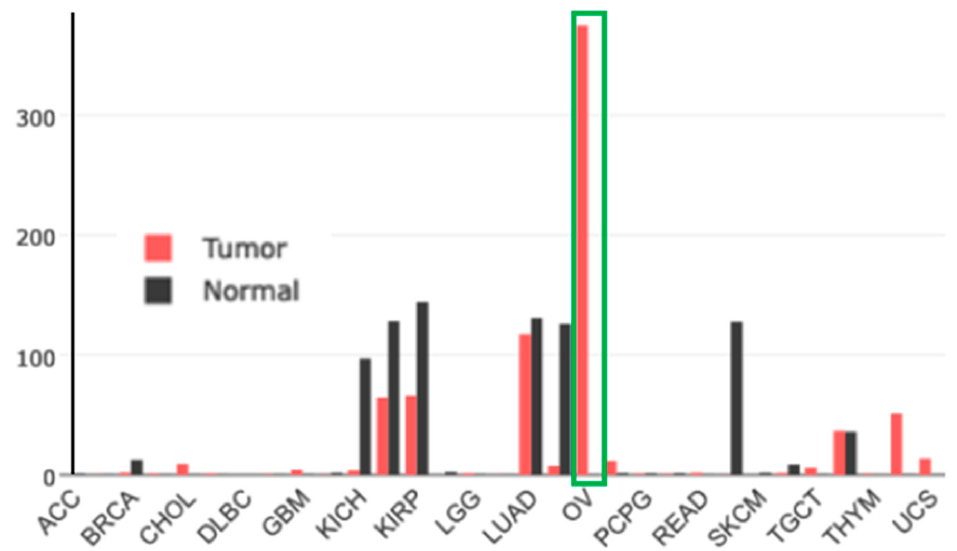
Figure 13. Gene-expression profile of FOLR1 in human normal and tumor tissue samples using the gene-expression profiling interactive analysis tool (http://gepia.cancer-pku.cn/ (accessed on 17 February 2023)). The cancer and normal ovarian samples are shown in the green rectangle. The height of the bar represents the median expression of the certain tumor type or normal tissue.